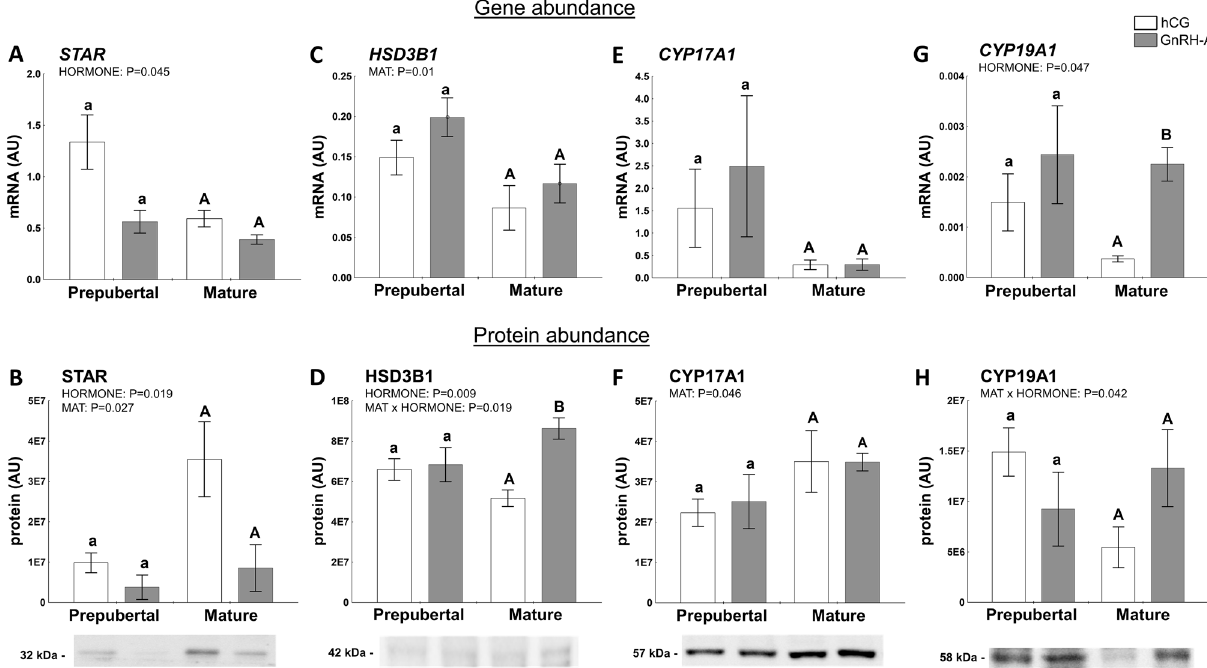
Figure 2. Hormones (hCG and GnRH-A; HORMONE) and sexual maturity status (prepuberty or maturity; MAT) change abundance of factors related to production of androgens and estrogens in ovarian follicles of prepubertal and mature gilts. The expression of STAR ( A , B ), HSD3B1 ( C , D ), CYP17A1 ( E , F ), and CYP19A1 ( G , H ) in prepubertal and mature gilts was evaluated. Gene expression was normalized to the geometric mean of ACTB and GAPDH (AU), identified as the best reference genes by NormFinder algorithm. Protein levels were normalized to total protein content (AU) using TGX Stain-Free gel technology ( B , D , F , H ). Uncropped blots are presented in Supplementary Fig. 3A online. Data were analyzed using two-way ANOVA with Sidak multiple comparison (mRNA) or Tukey (protein) post-hoc tests and are presented as mean ± SEM (n = 5–6 per group). Means with different superscripts differ significantly (small letters—prepubertal gilts, capital letters—mature gilts; P < 0.05). AU—arbitrary units.